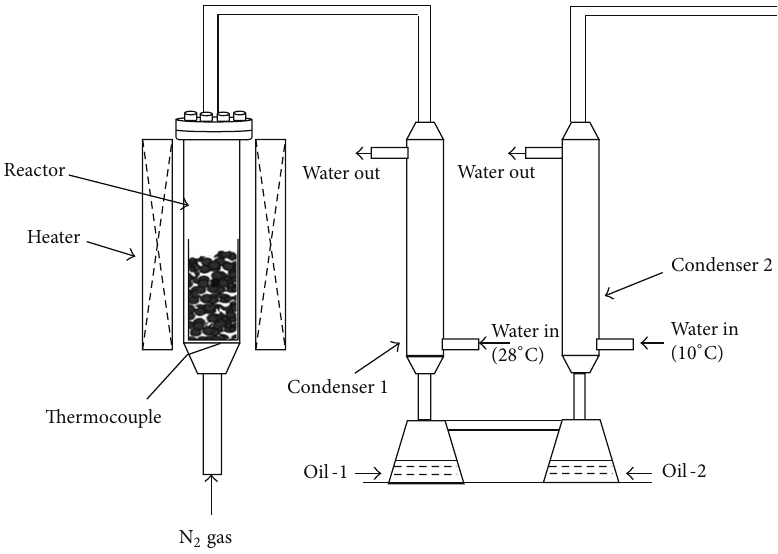
Figure 2: Schematic model of the experimental